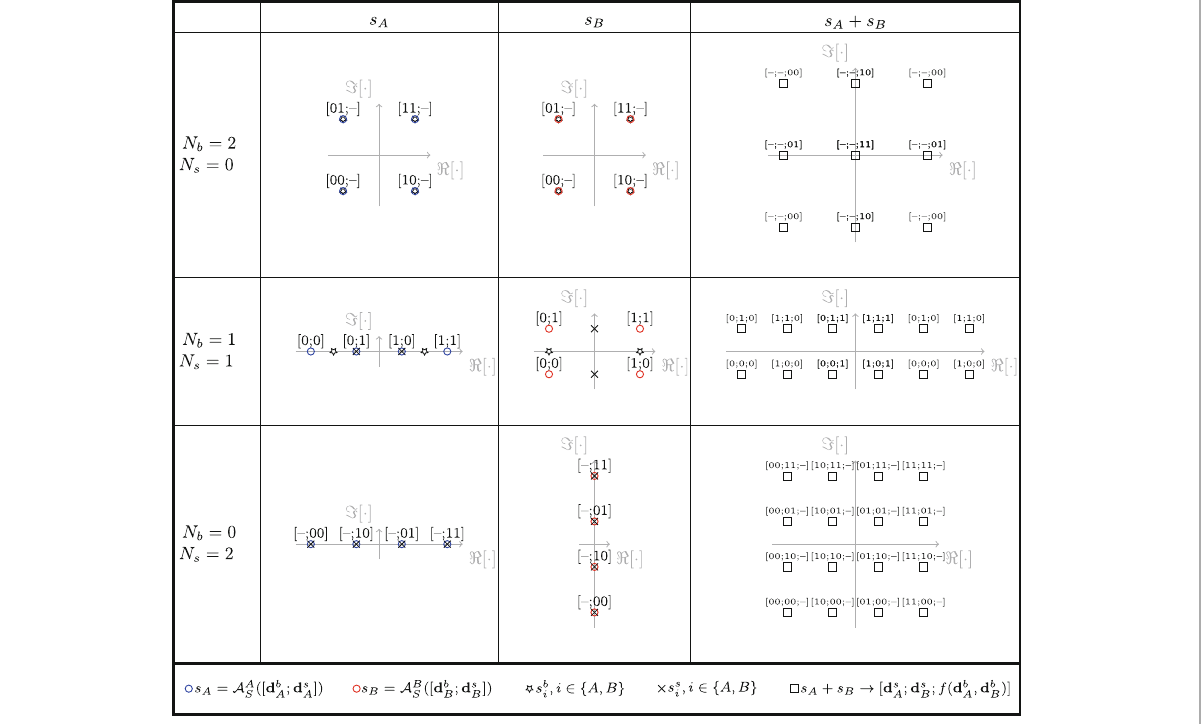
Fig. 4 Proposed constellation design for ( N b , N s ) = { ( 2,0 ) ; ( 1,1 ) ; ( 0,2 )